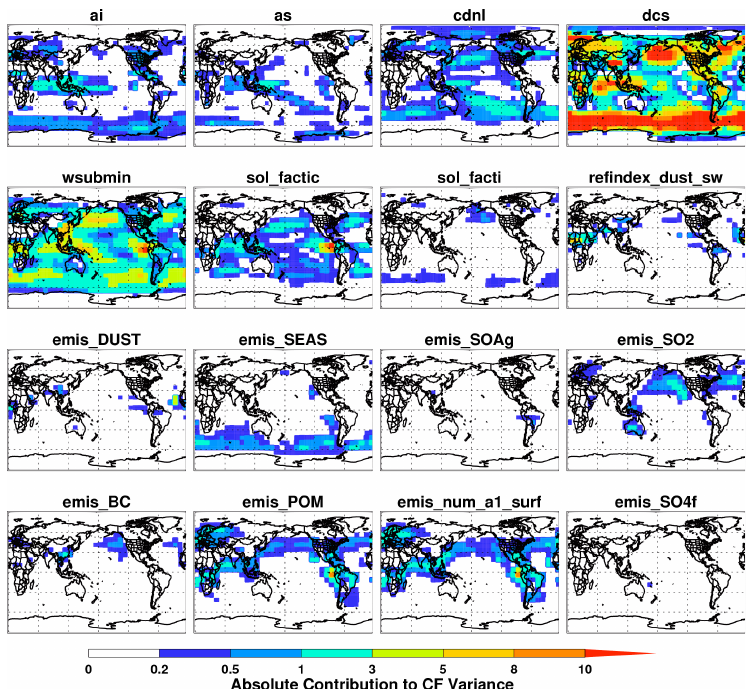
Figure 11 Global spatial distribution of absolute CF variance (unit in W 2 /m 4 ) in response 1118 Fig. 11. Global spatial distribution of absolute CF variance (unit in W 2 m − 4 ) in response to the perturbation of each of the 16 input parameters predicted by the GLM. to the perturbation of each of the 16 input parameters predicted by the GLM. 1119